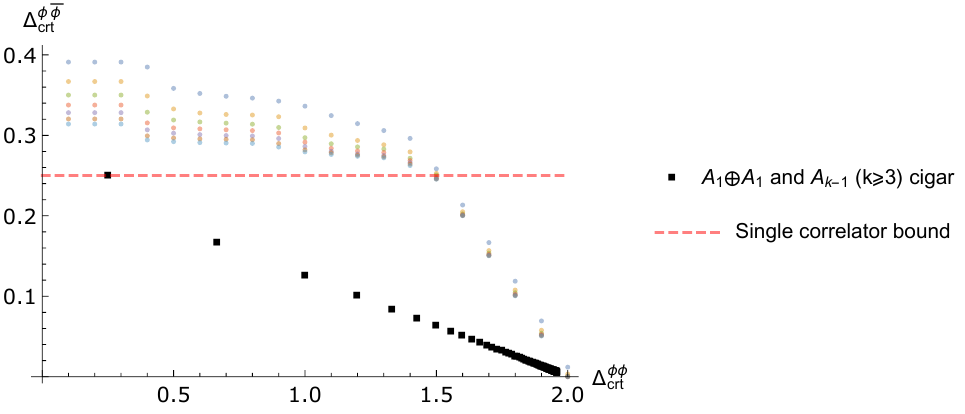
Figure 9 . The circle dots indicate upper bounds ( b (cid:1) (cid:30)(cid:30) lowest scaling dimension in the respective OPEs, at derivative orders ranging from 8 to 20. At in(cid:12)nite order, the bound cannot be worse than the single correlator bound 0.25 indicated by the dashed line. We also (cid:12)nd that (cid:1) (cid:30)(cid:30) dots indicate the values for the A 1 A cigar k (cid:0) 1